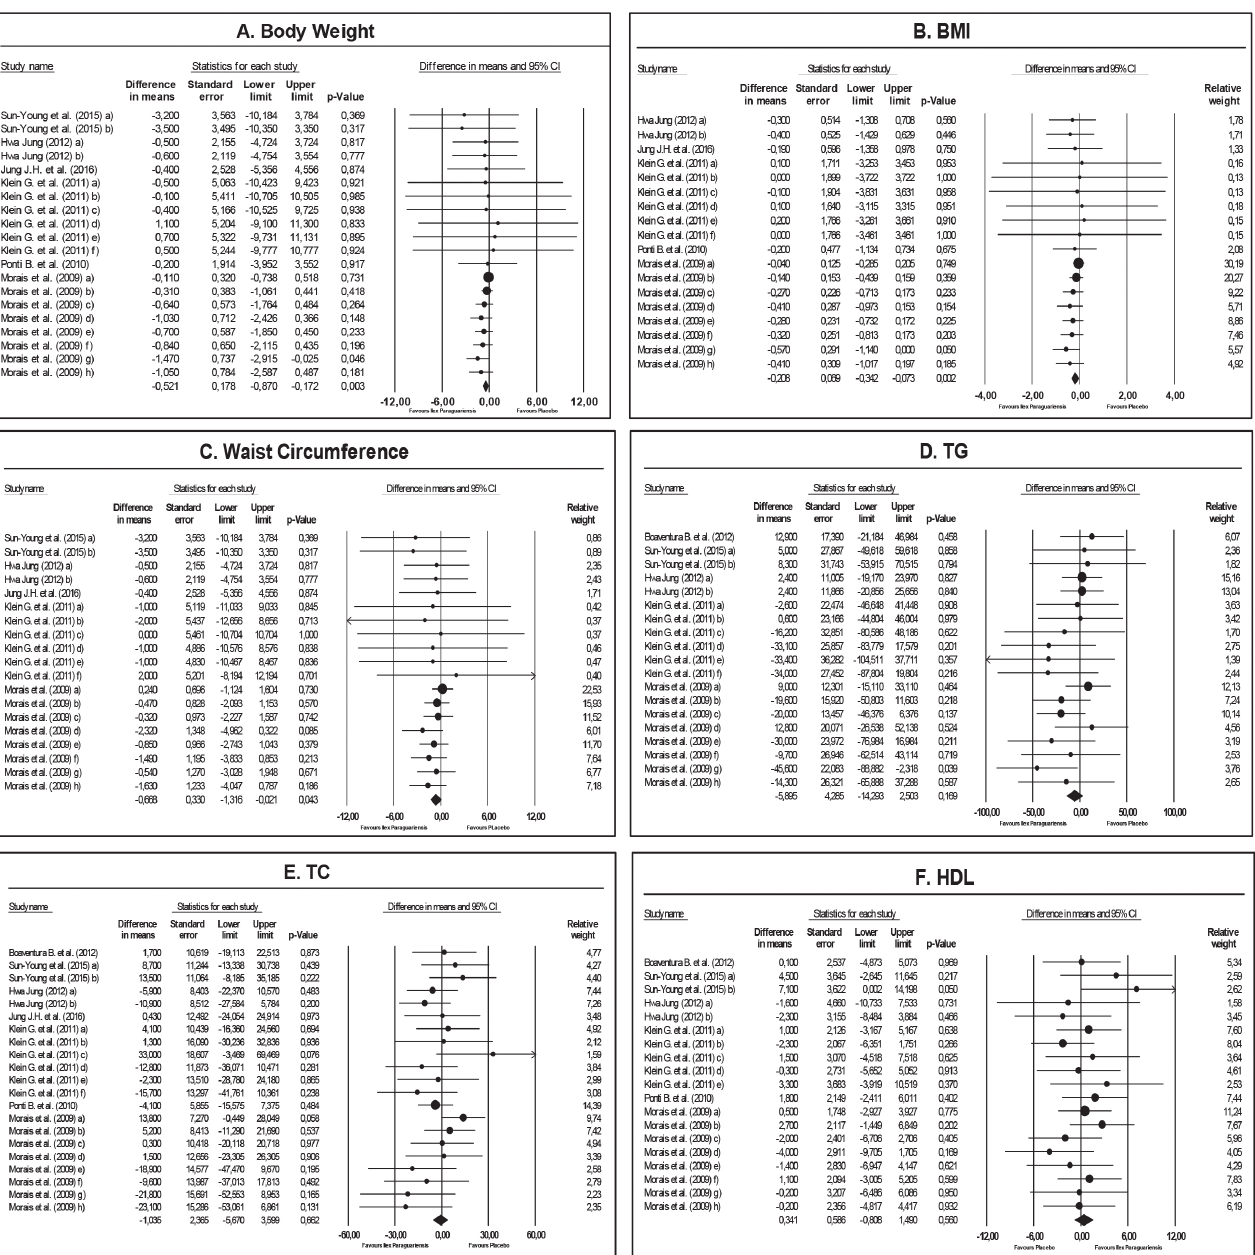
FIGURE 3 - Forest plots of comparisons of the effects I. paraguariensis consumption on the outcomes of this meta-analysis, compared with control arms. BMI – body mass index; DBP – diastolic blood pressure; HDL – HDL-cholesterol; LDL – LDL- cholesterol; SBP – systolic blood pressure; TC – total cholesterol; TG –